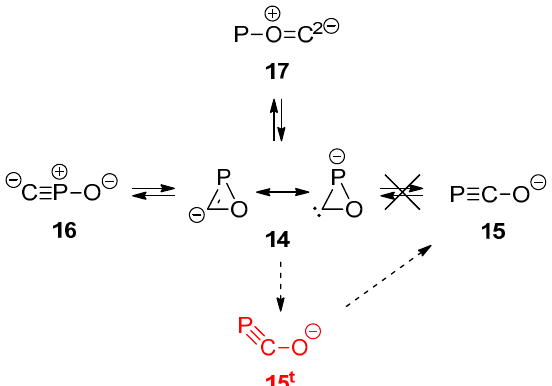
Scheme 4. Isomers derived from oxaphosphirenide 14 . Singlet (closed-shell) structures represented in black and triplet ones in